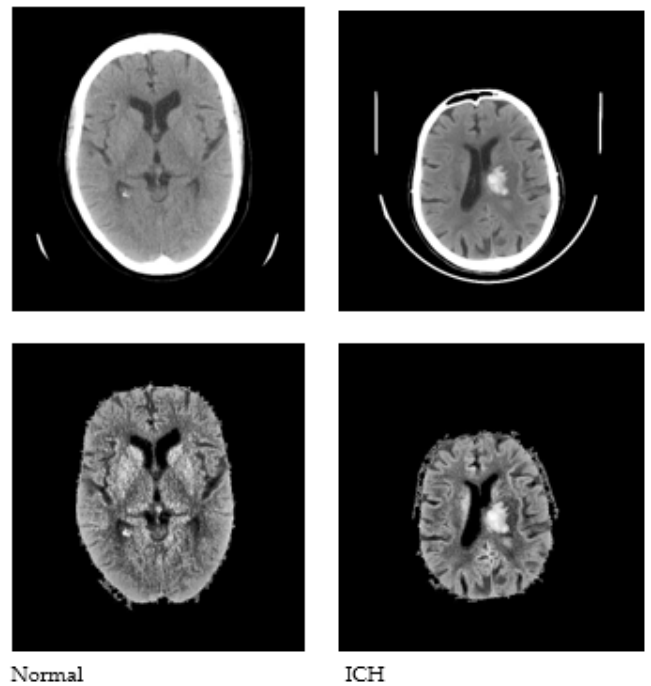
Figure 3. Sample CT images after pre-processing.